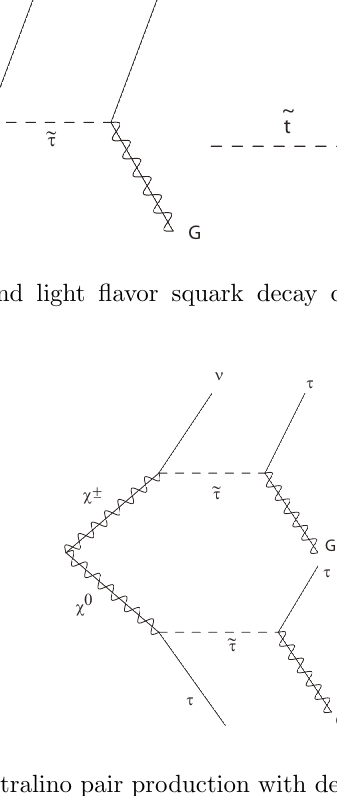
Figure 3 . Chargino Neutralino pair production with decay chains through stau